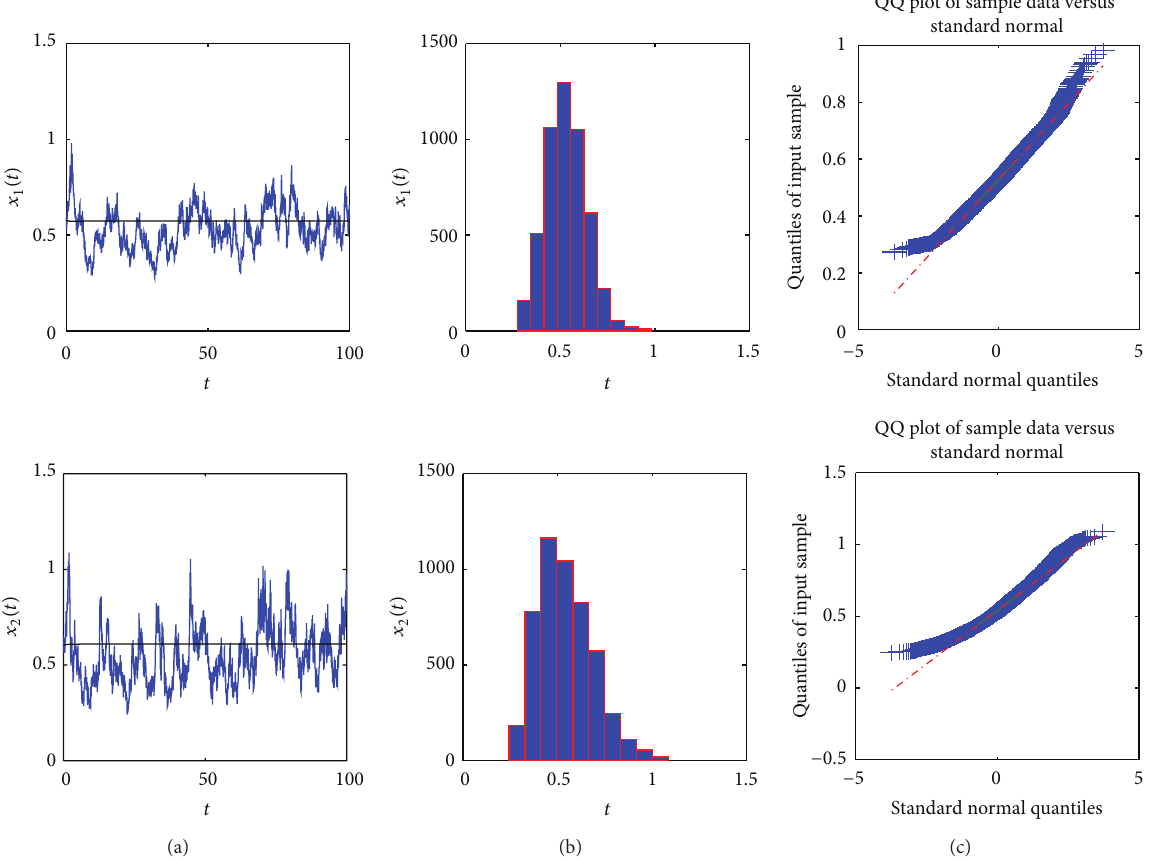
Figure 2: The subgraphs are defined as in Figure 1. 𝜎 1 = 0.2 , 𝜎 2 = 0.3 . The stochastic system is stochastically permanent and persistent in mean and has a stationary